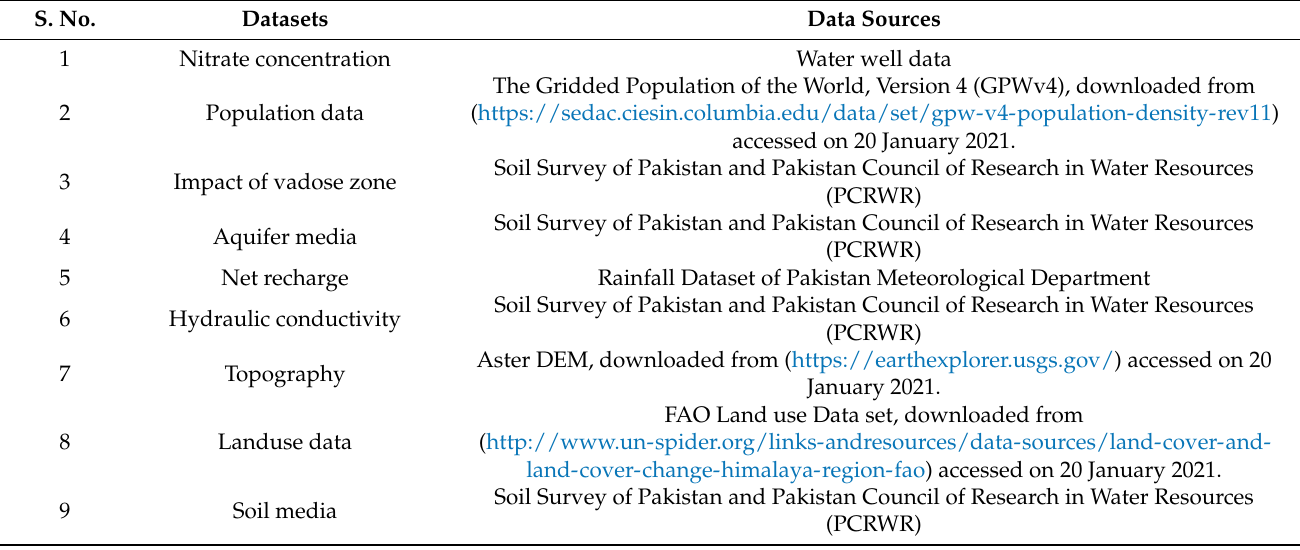
Table 1. Model validation and data sources for all factors.